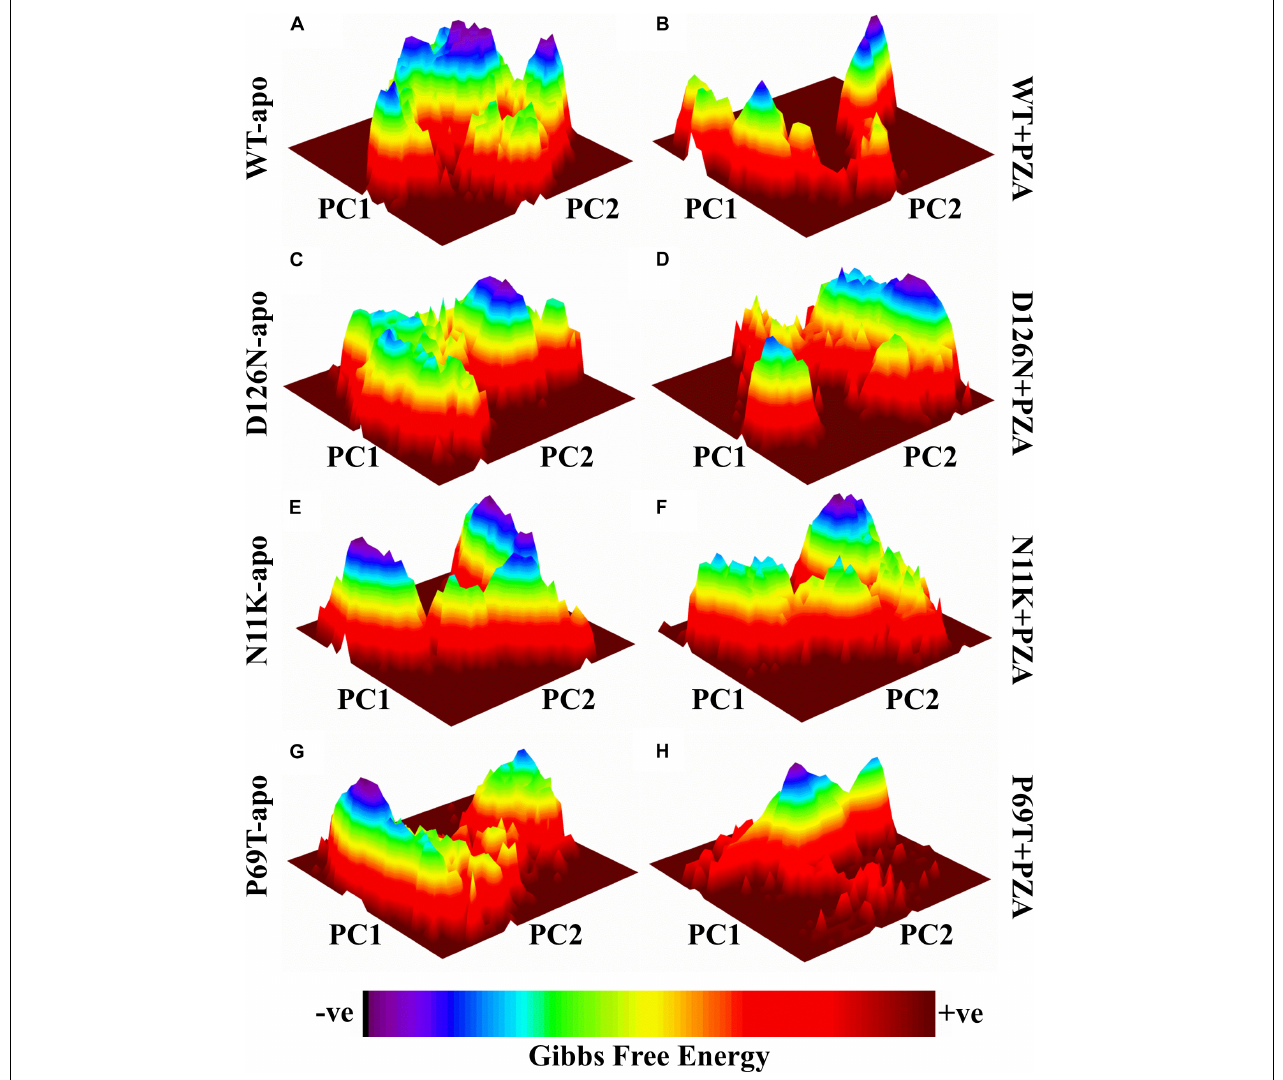
FIGURE 1 | Gibbs free energy of PZase and mutants (N11K, P69T and D126N) in apo and complex state with PZA. The Gibbs free energy landscape for wild and mutated proteins in their apo and wild states is depicted along with their value bars against PC1 and PC2. Noticeable differences can be observed. The red color represents the high energy state, yellow and green low and blue represents the lowest stable state. (A) WT apo (without bound PZA) in comparison with MTs apo have been shown (C,E,G) . (B) WT complex (bound with PZA) in comparison with MTs complex (D,F,H)